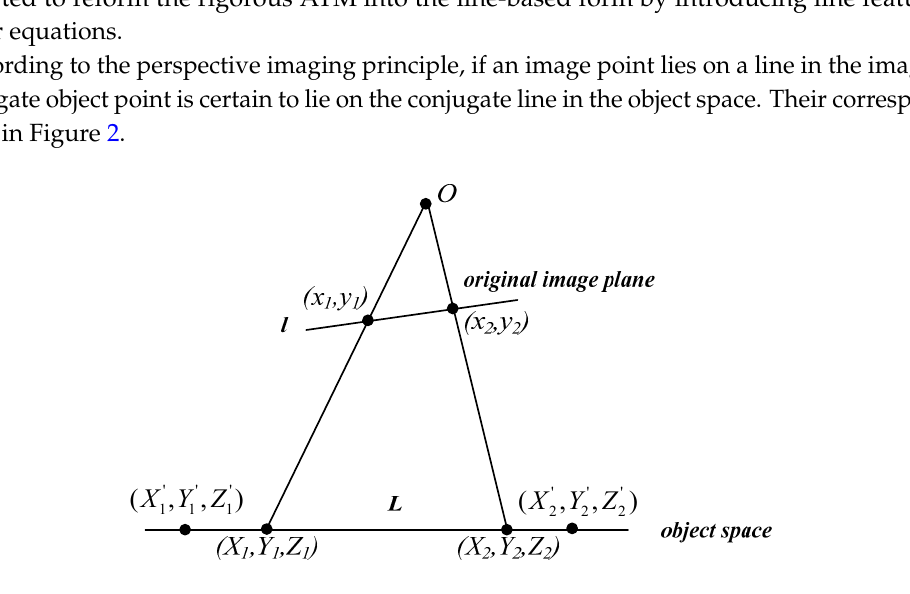
Figure 2. Correspondence of conjugate points on conjugate lines in the image space and the object space.